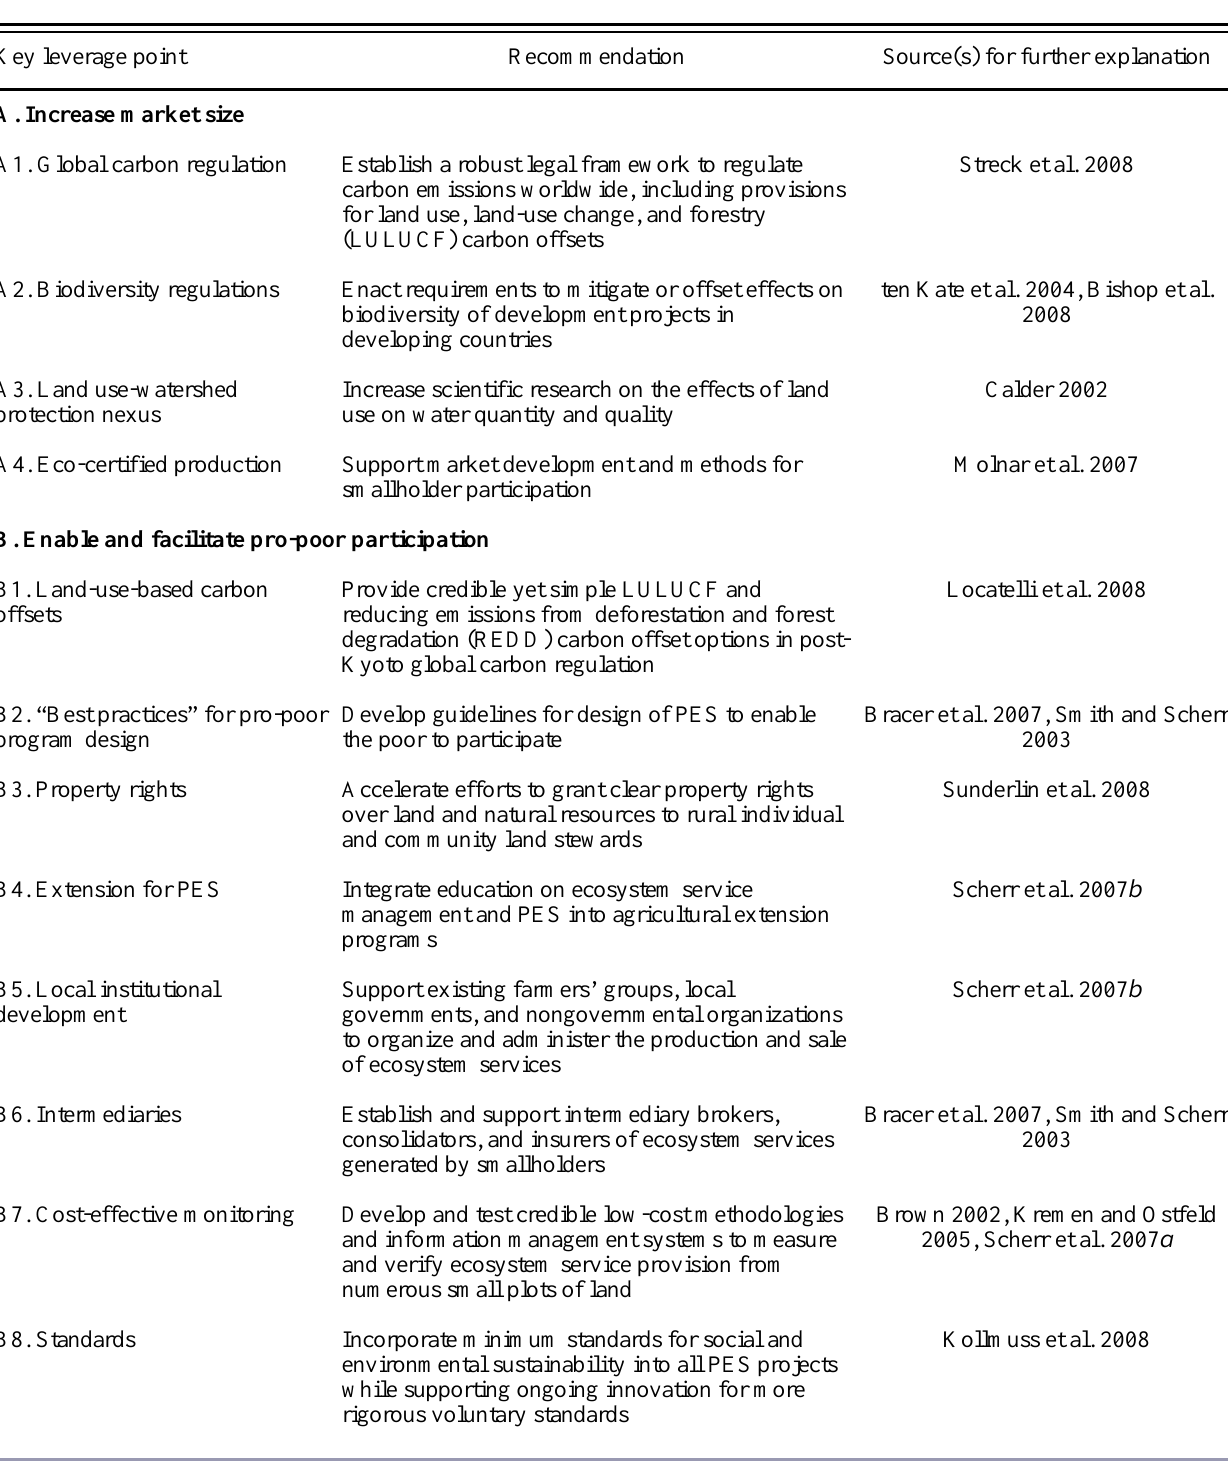
Table 3. Key leverage points for shaping pro-poor payment for ecosystem services (PES). We define these as factors that are both critical to the future shape of ecosystem service markets and amenable to influence through programs of advocacy, support, or